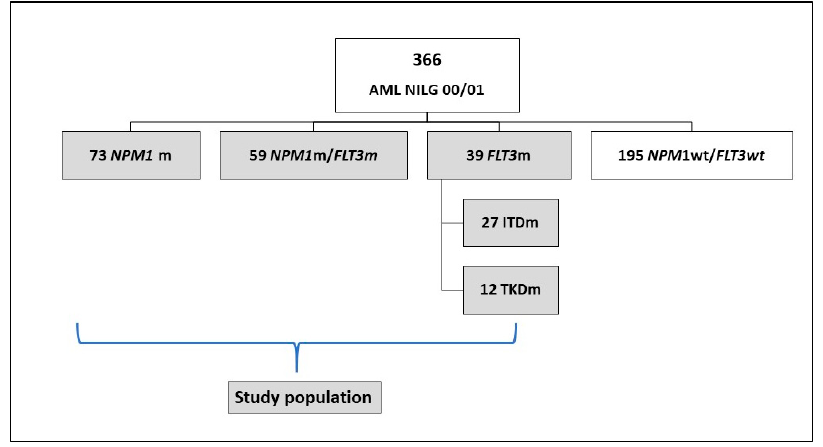
Figure 1. Study Cohort. Table 1. Characteristics of 171 NPM1 or FLT3 -mutated patients (study cohort), divided according to molecular data.